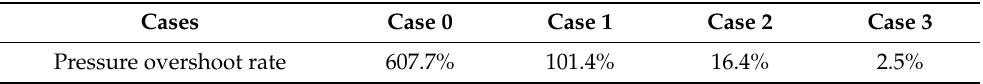
Table 4. Table of pressure overshoot values for different structures.